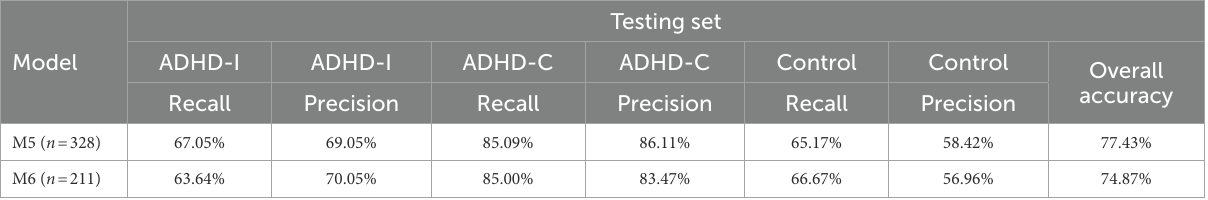
TABLE 6 Model performance of the cross-validated testing set with